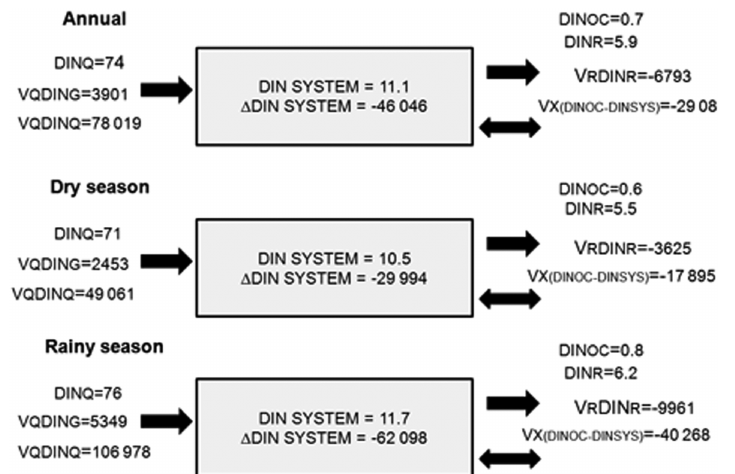
Fig. 5 – Annual and seasonal nitrogen flux (in moles d − 1 ) budget at the BJE. ( + ) indicates source, and ( − ) indicates sink.